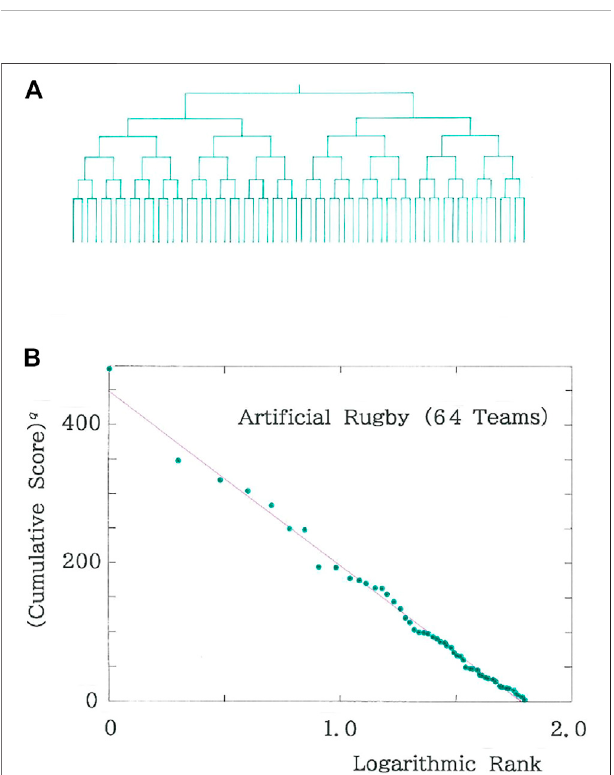
FIGURE 7 | Final results of an arti fi cial rugby with 64 teams. (A) Tournament diagram. (B) Rank dependence of the q -th power of cumulative score.Thepurpledeclininglineindicatestheoptimized fi t(| r | (cid:1) 0.9963with d (cid:1) 1.477 for n (cid:1) 57, with 7 ties being included). The ties are processed according to a standard